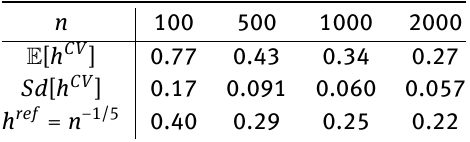
Table 4: Expectation and standard deviation of the bandwidth selected by cross-validation as a function of the sample size n , and comparison with bandwidth h ref chosen by the